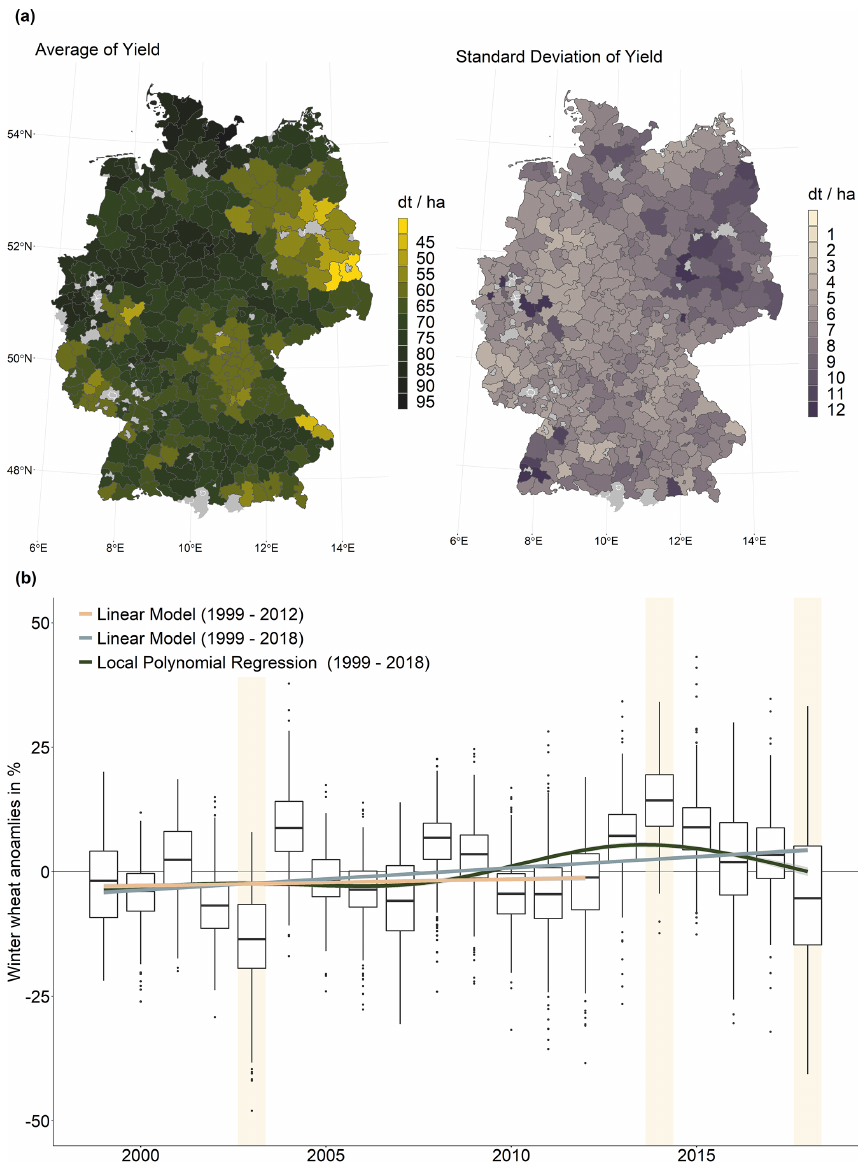
Figure 1. (a) Twenty-year winter wheat yield average (1999–2018, left) and standard deviation (right) of yields for the districts over Germany. (b) Box-and-whisker plots of winter wheat anomalies for each year and both linear and non-linear model fits to identify significant trends in the anomaly data. The exceptional years 2003, 2014, and 2018 are marked with a light beige box. Data source: Federal Statistical Office